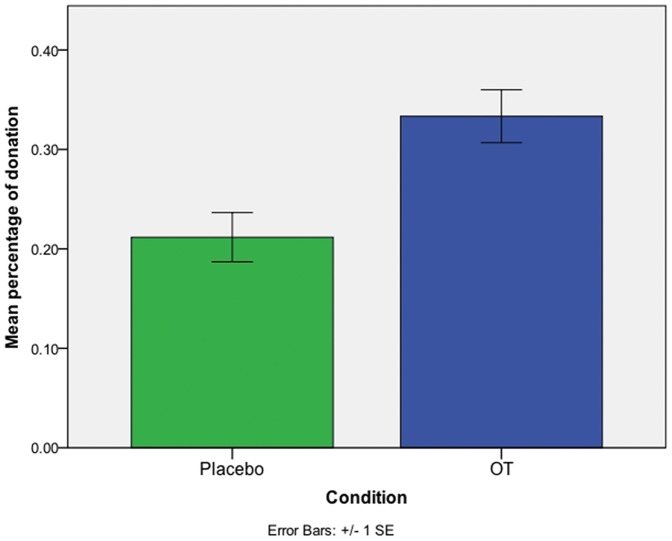
Main effect of OT infusion on percent donated after viewing a PSA.Participants who received OT donated money to 33% of ads for which they correctly answered the content question, while those on placebo donated to 21% of eligible ads ( = 10.835, p = .001). The bar represents one standard error. There was no difference between groups in the proportion of correct answers to a question about the ad's content (OT: 93.8%, placebo: 90.1%;  = 2.891, p = .091)